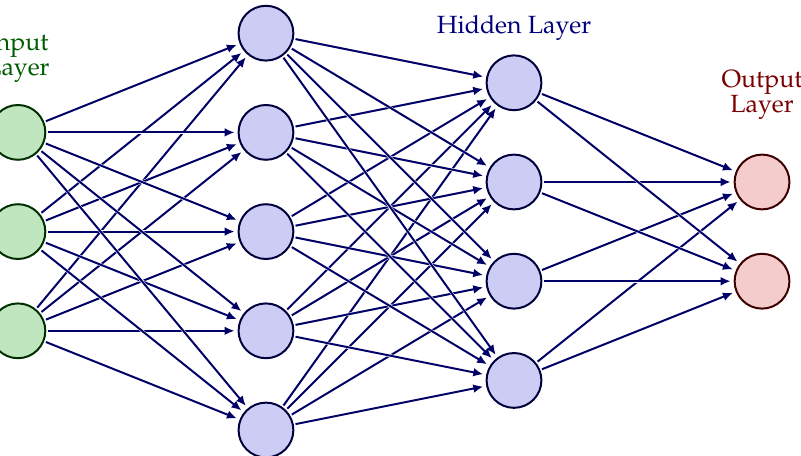
Figure 1. Example of Deep Neural Network Schema. In green the neurons of input layer, in blue the neurons of hidden layers and in red the neurons of output